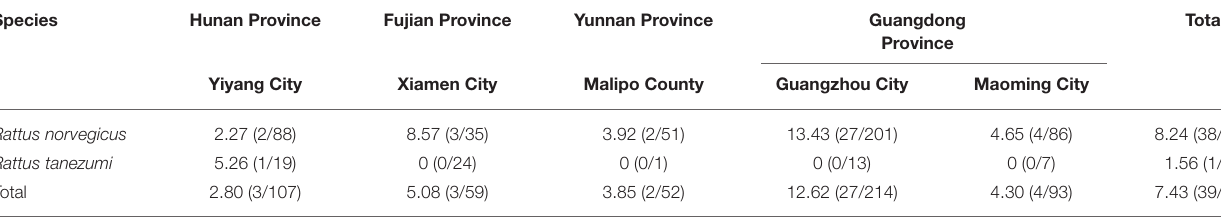
TABLE 1 | Detection of Seoul virus in liver tissue samples from the trapped animals. Species